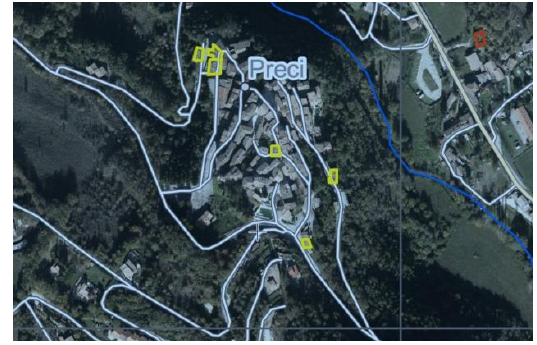
Figure 2. Grading map of the city of